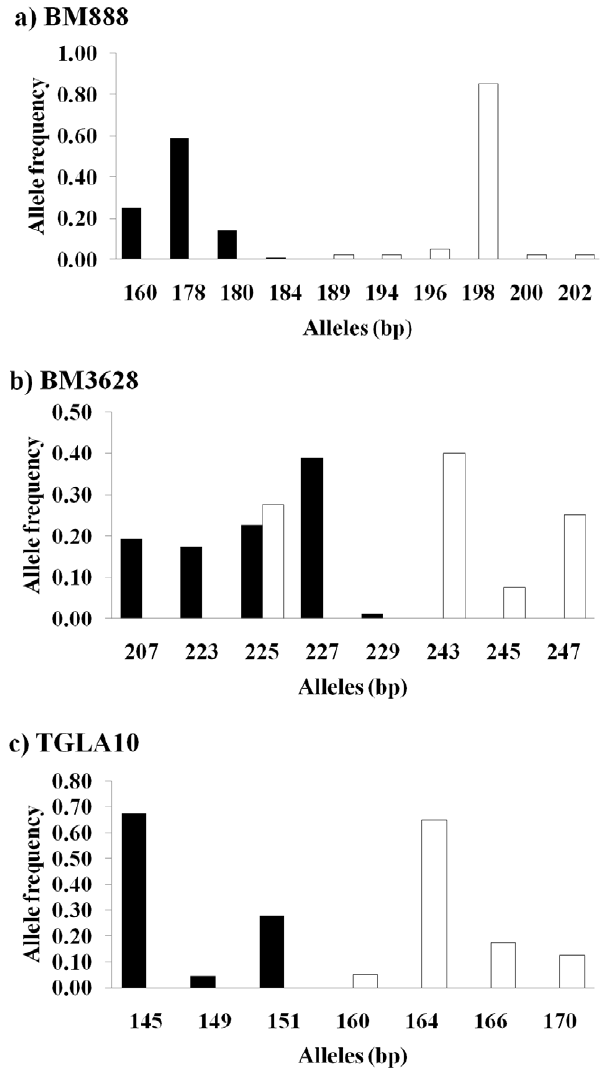
Figure 2. Microsatellite allele distributions in Chinese and Korean water deer populations. The cross-specific microsatellites were originally developed from cattle [25]. Black bars incidate frequency of allele size in Chinese water deer population and white bars in Korean water deer population. (a) BM888 locus (b) BM3628 locus (c) TGLA10